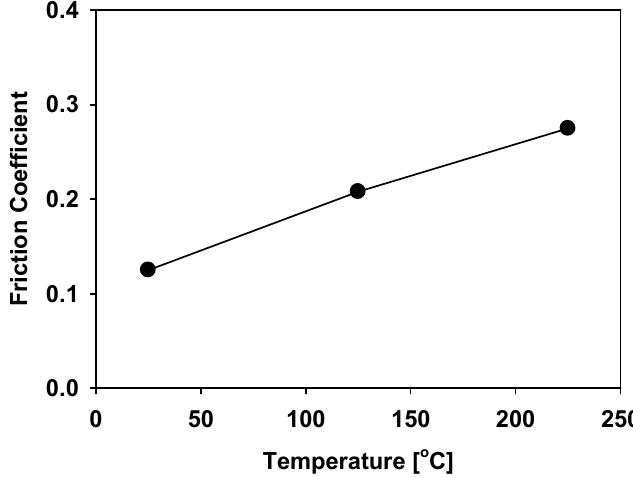
Figure 3. Measured friction coefficients at various temperatures.